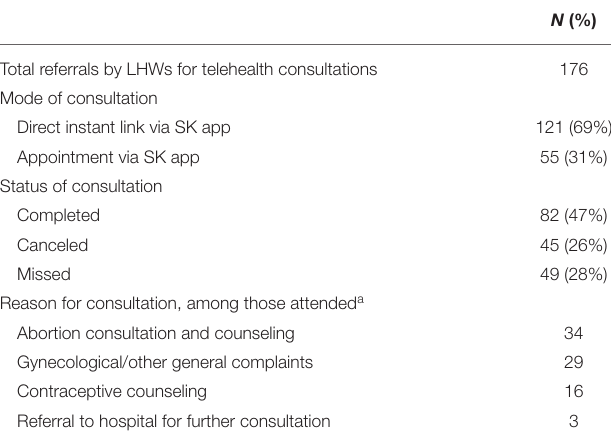
TABLE 1 | Referrals by LHWs via the SK app ( n = 176), June 2020–March